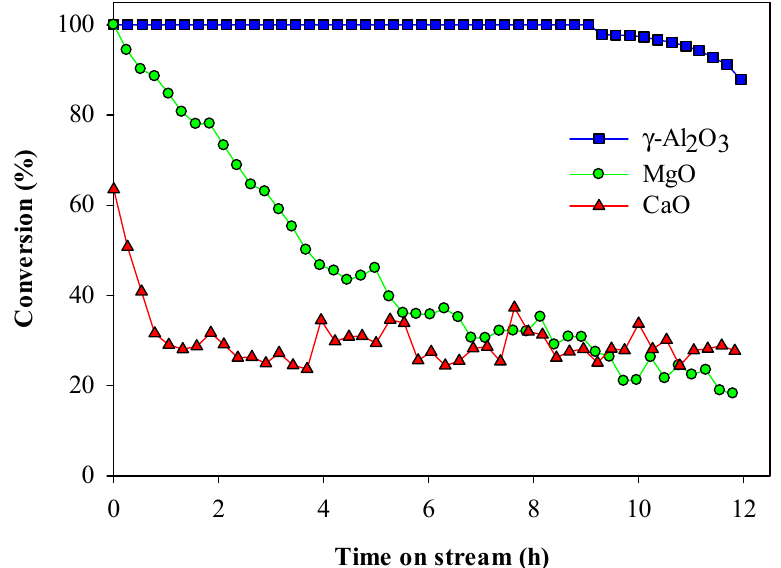
Figure 2. The changes of HFC-134a conversion efficiencies during continuous reaction of HFC-134a over γ -Al 2 O 3 , MgO, and CaO for 12 hours at 600 ℃ .